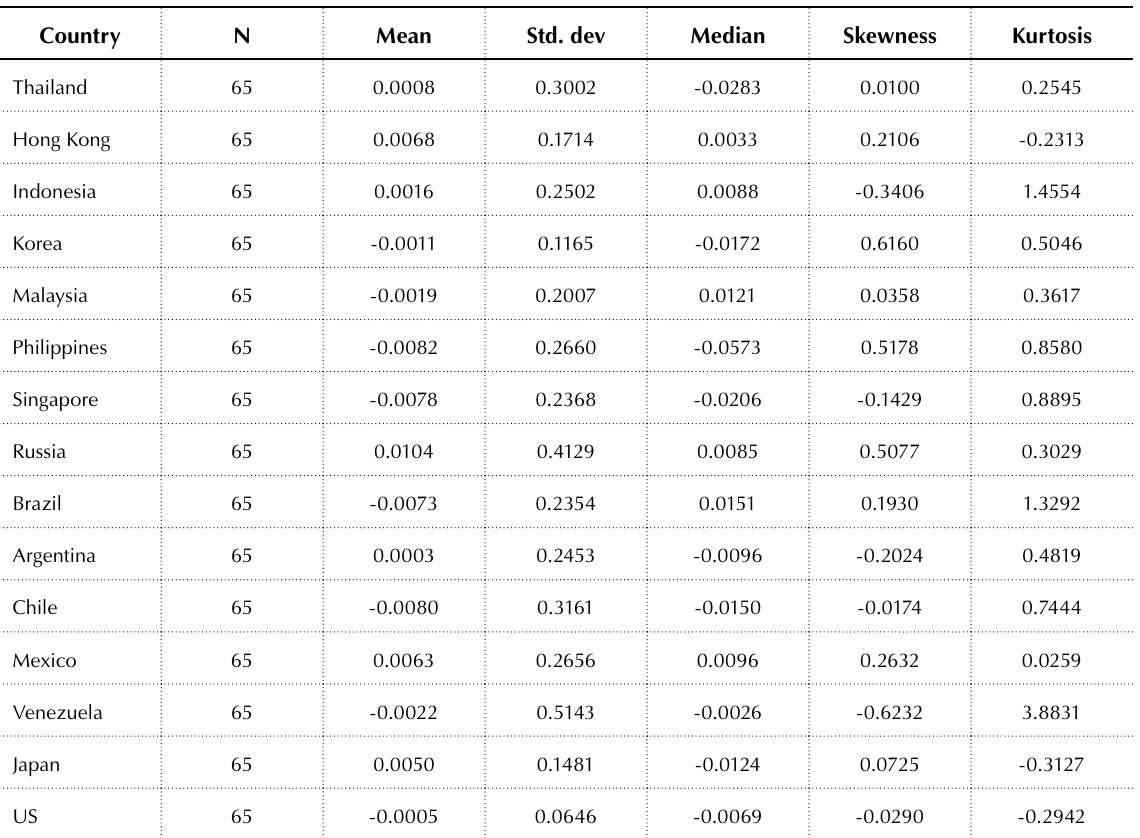
Table 1 (cont.). Summary